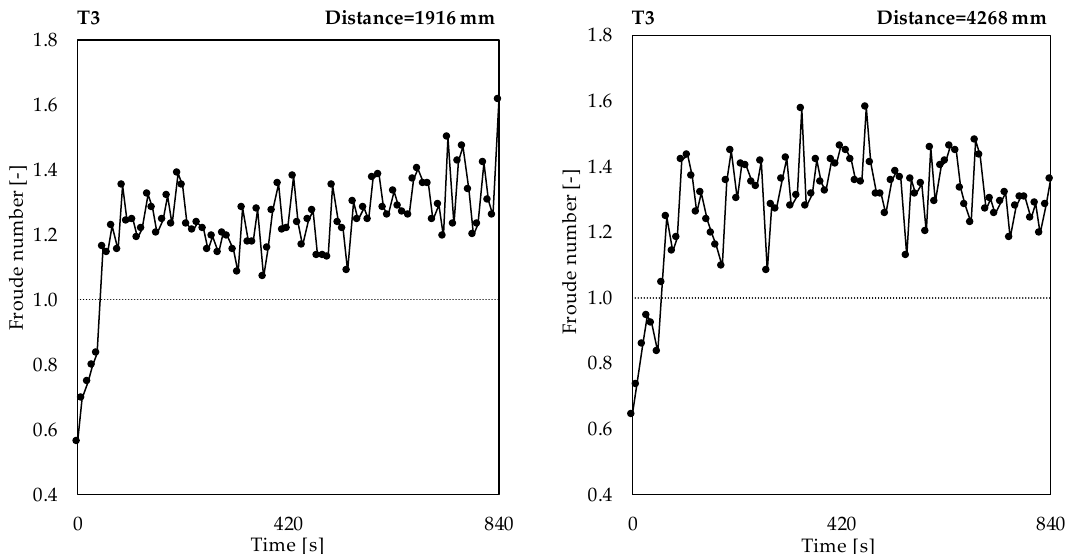
Figure 6. Temporal evolution of the Froude number at two different locations along the channel during the aggradation test T3.